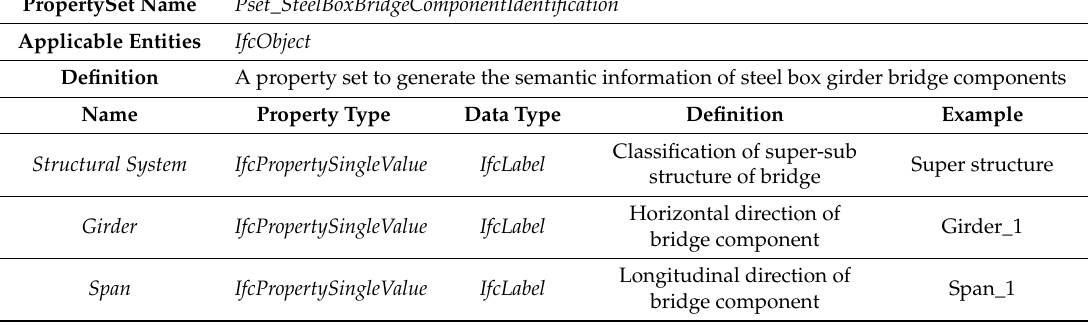
User-defined PSET for generating the semantic information of steel box girder bridge